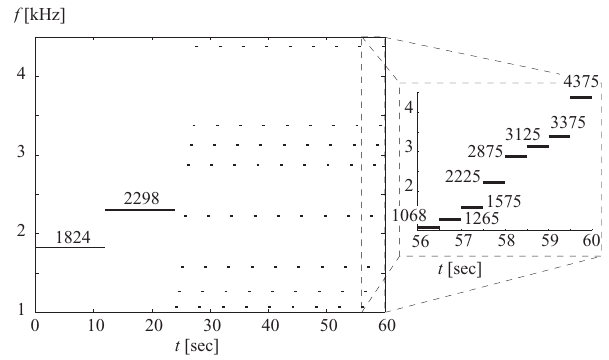
Fig. 2. Schematic spectrogram (to scale) of the transmission pat- tern used by the HAARP HF facility to heat the ionosphere. The ELF/VLF waves were AM modulated onto carrier frequencies of 3.3MHz and 5.8MHz, alternating between both. The term “Sinu- soidal wave modulation” refers to the waveform used at each of the frequencies transmitted. The transmitted HF wave was in the X